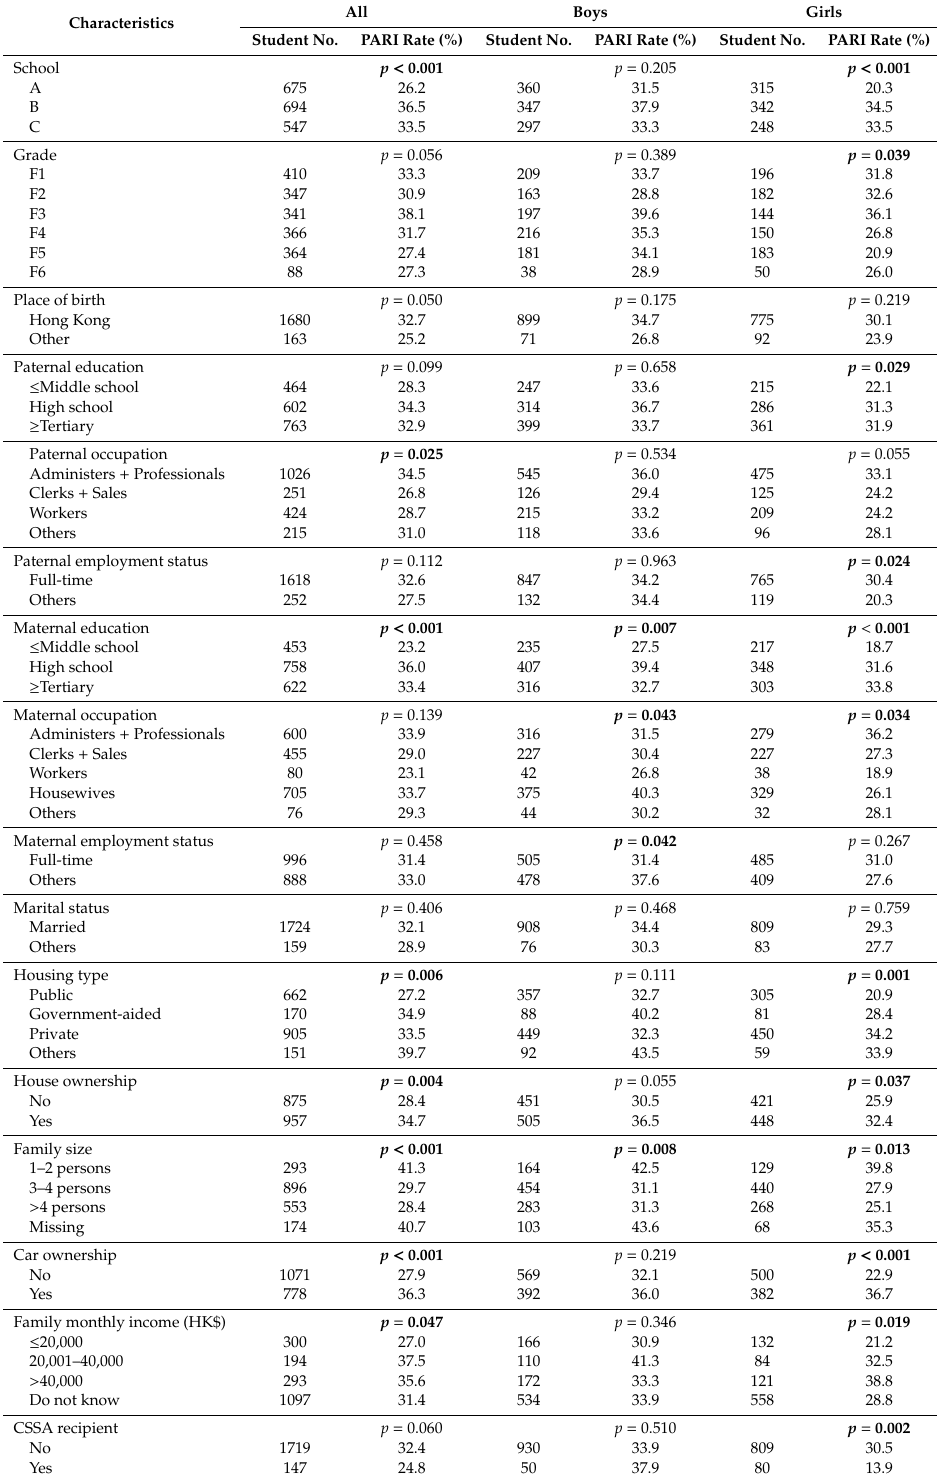
Table 1. Physical activity-related injury (PARI) incidence rate (%) by sociodemographic characteristics of the participants.